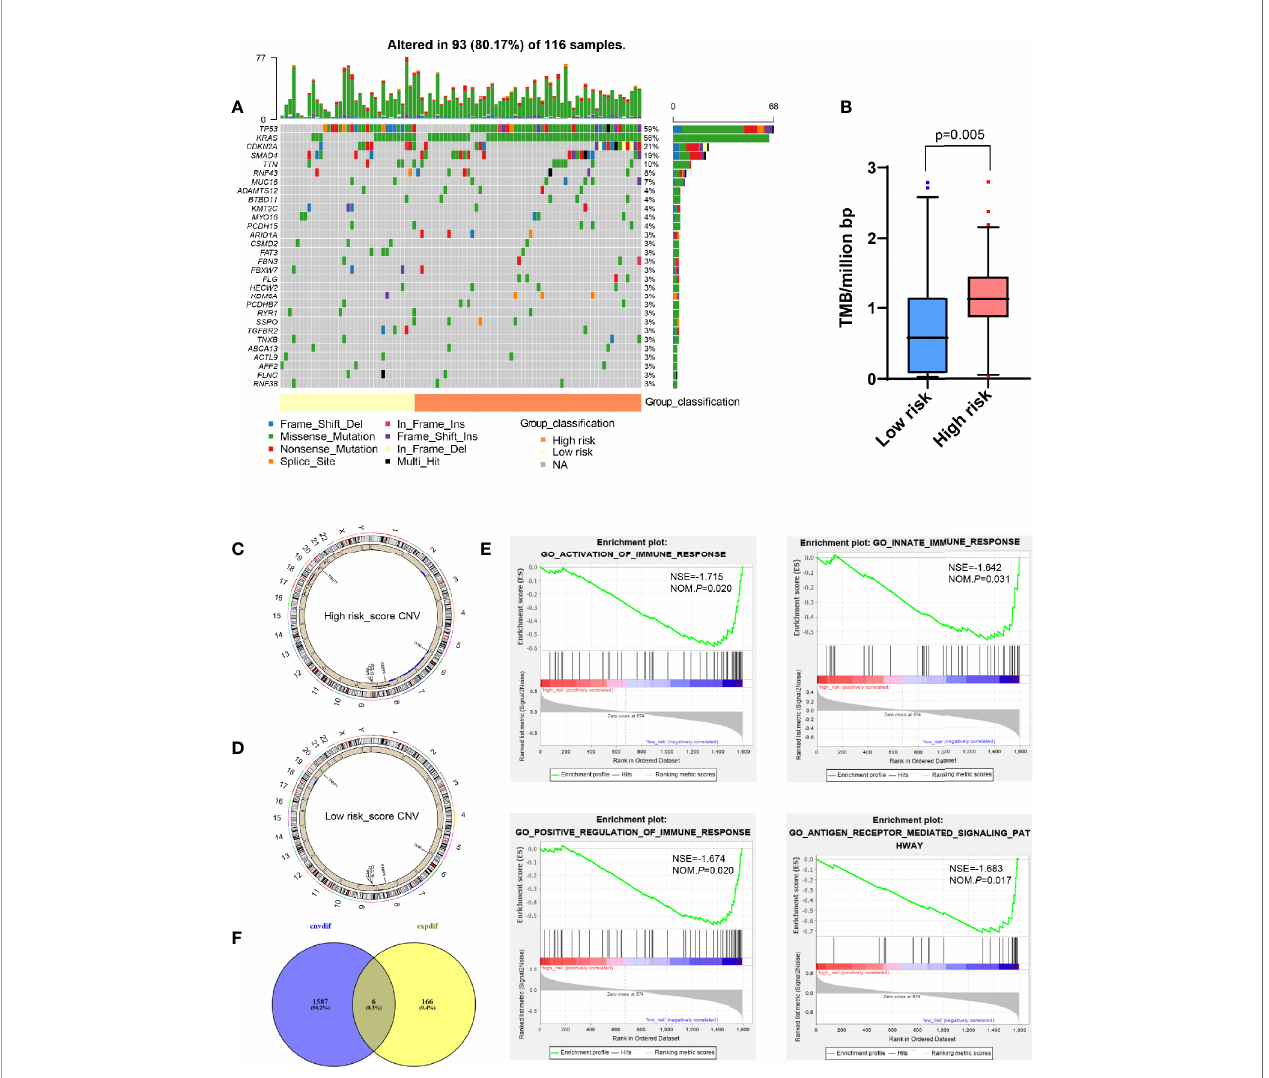
FIGURE 5 | Analysis of whole-exome sequencing data showed the difference between high and low risk-score groups. (A) Oncoplots for TMB analysis between high and low risk-score groups, showing the top 30 mutated genes. The upper barplot indicates the number of mutations per sample, while the right barplot shows the number of mutations per gene. The mutation types were added as annotations at the bottom. (B) Box plot to show the TMB between high and low risk-score groups. (C, D) Circos plot for CNV in high and low risk-score groups, respectively. The outermost layer is the chromosome model, and the next two layers illustrate the CNV (single copy ampli fi cation is shown in black dots, double even multiple copy ampli fi cation is in red dots, and deletion is in blue dots). (E) Venn diagram analysis between the different CNV and DEGs from transcriptome. (F) GSEA for different CNVs. The vertical axis represents enrichment score. The enrichment score increased with the number of enriched genes and vice versa. CNV, copy number variation; GSEA, Gene Set Enrichment Analysis; ES, Enrichment Score; NES, Normalized Enrichment Score; TMB, tumor mutation burden; DEGs, differentially expressed